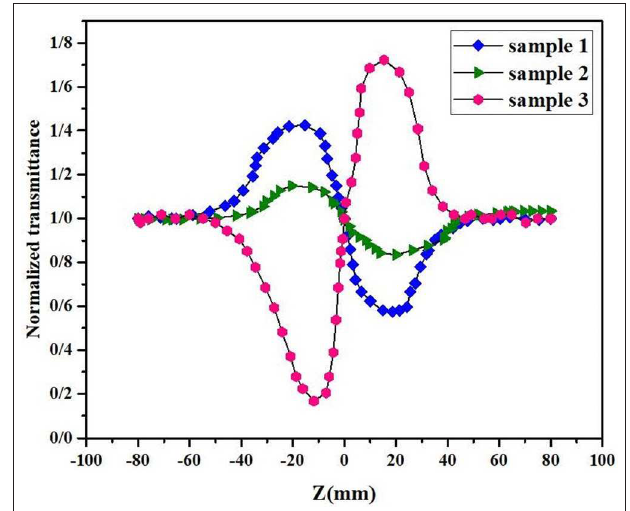
FIGURE 4 | Closed aperture Z-scan traces of MoS 2 nanoflakes with various thickness: 150nm (sample 1), 230nm (sample 2), and 420nm (sample 3).